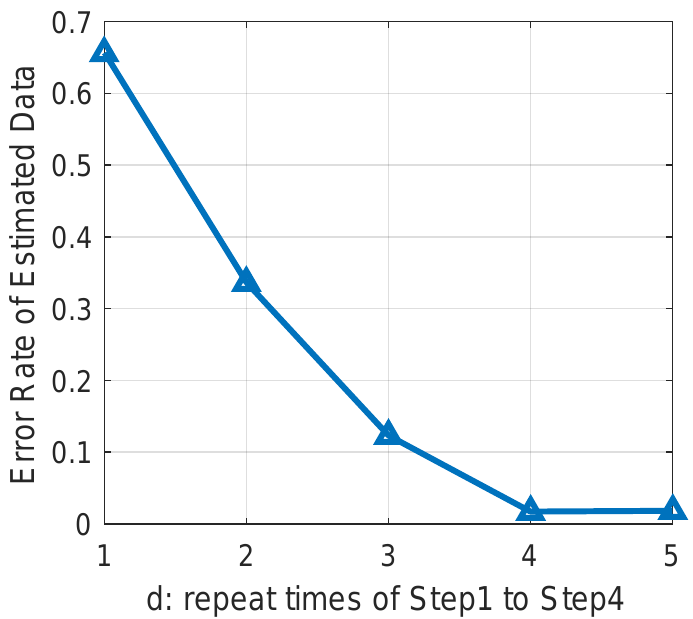
Figure 6. Error rate of estimated data affected by the value of d , where n = 20,000.